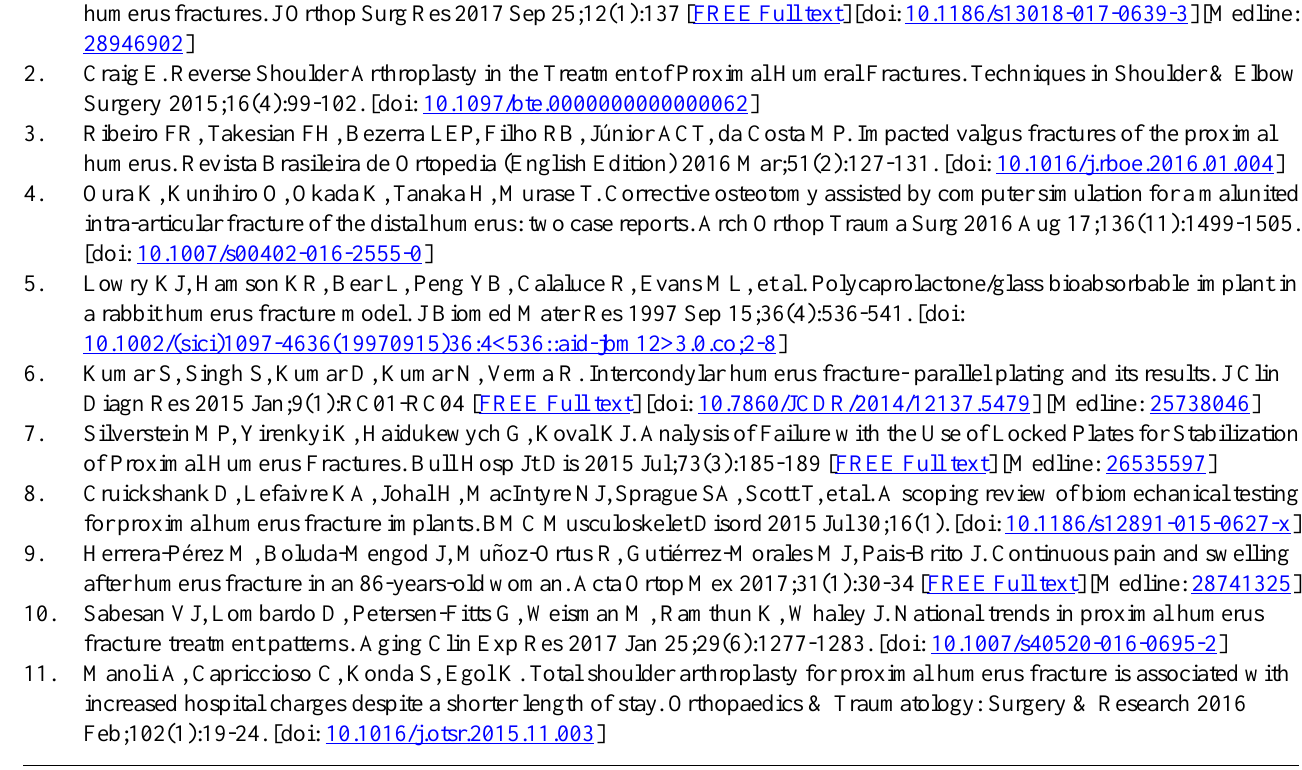
ICF: Ilizarov circular fixator LCP: locking compression